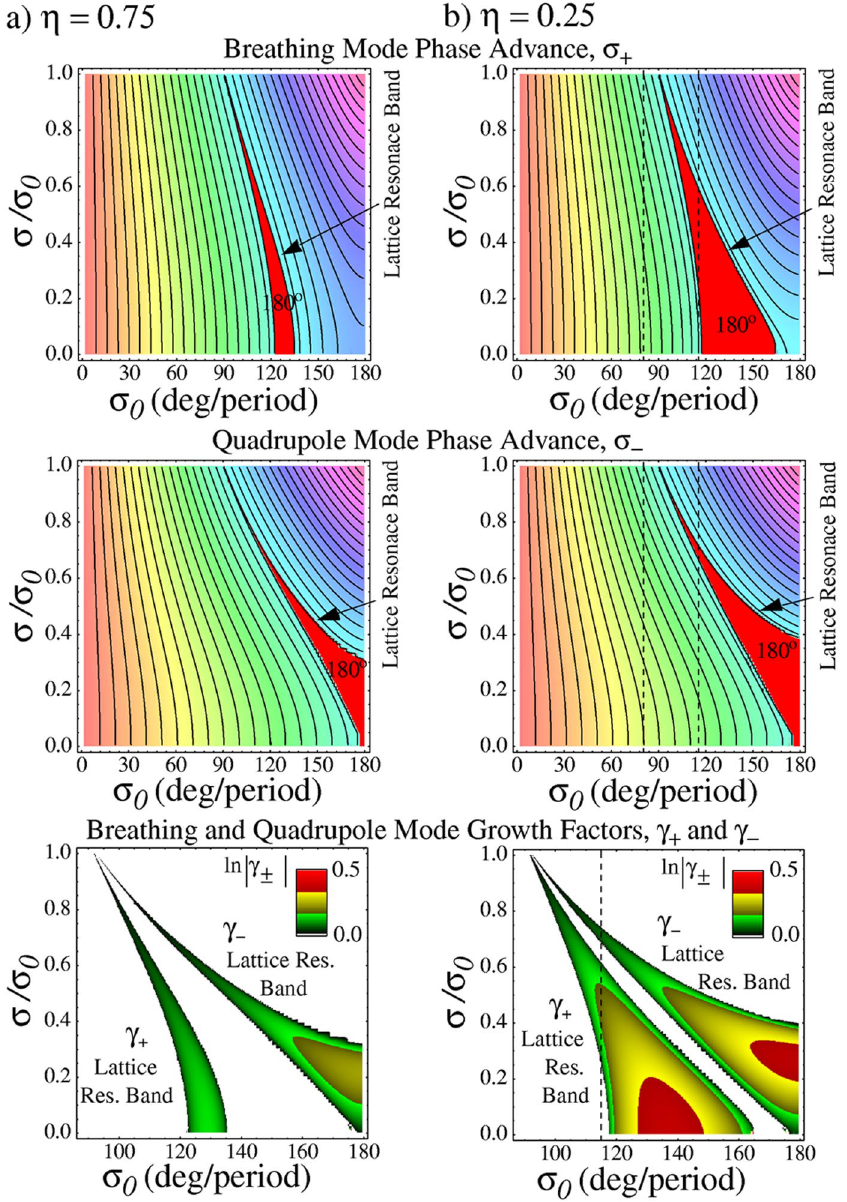
FIG. 12. (Color) Contours of (upper row) breathing and (middle row) quadrupole mode phase advances ( (cid:24) (cid:16) ) and (bottom row) and (cid:24)=(cid:24) for a solenoidal focusing channel. Results are shown for occupancies (cid:31) (cid:1) 0 : 75 growth factors ( (cid:6) (cid:16) ) as a function of (cid:24) 0 0 and (cid:31) (cid:1) 0 : 25 in columns (a) and (b). In the upper and middle rows, black contour lines correspond to (cid:24) (cid:16) (cid:1) 10 (cid:31) , 20 (cid:31) , 30 (cid:31) ; . . . , and colors vary continuously with changes in (cid:24) (cid:16) (bands of instability with (cid:24) (cid:16) (cid:1) 180 (cid:31) are marked in solid red for emphasis). In the lower row, values of ln (cid:3) (cid:6) (cid:16) (cid:4) with (cid:6) (cid:16) > 1 are labeled with continuously varying colors as indicated in the key. Identical color schemes are used in (a) and (b) to measure mode phase advances and growth factors.Vertical dashed lines in the plots for (cid:31) (cid:1) 0 : 25 correspond to the cross-section plots in Fig.